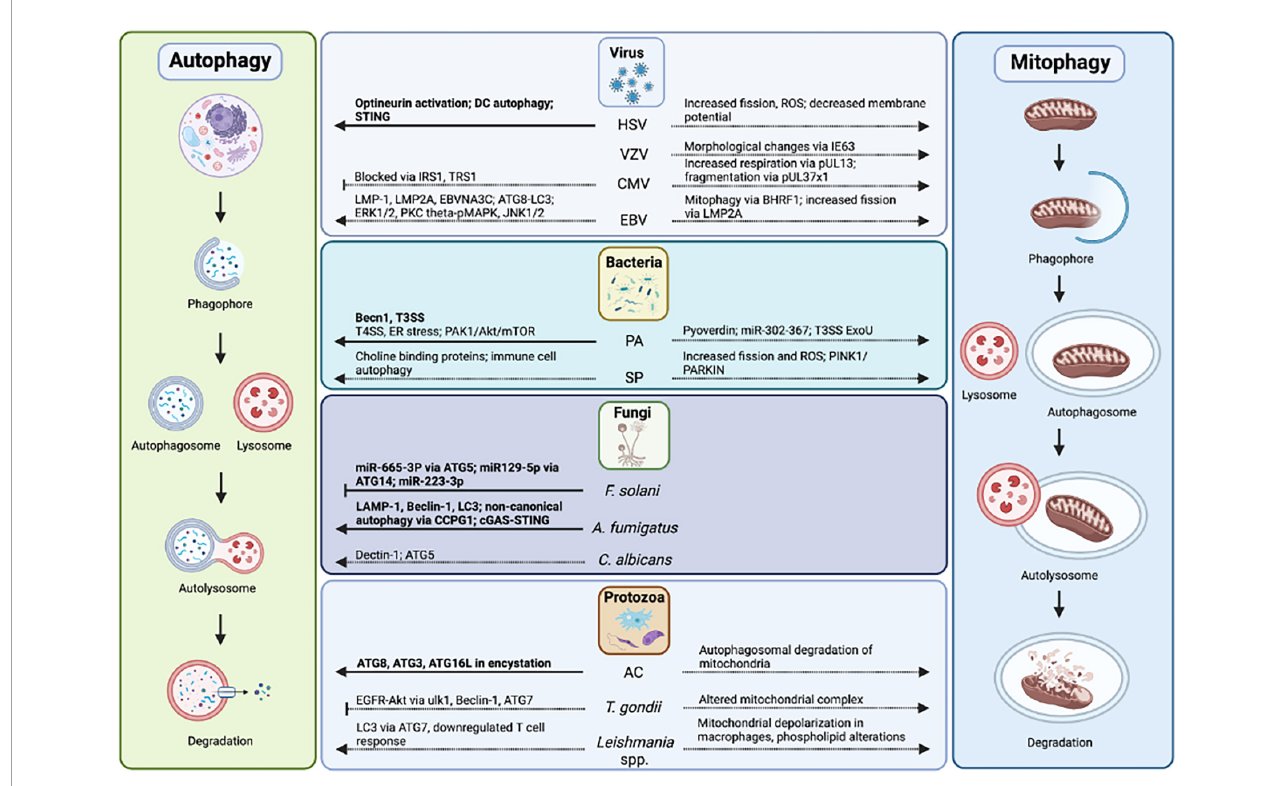
FIGURE5 Autophagy and mitophagy in infectious keratitis. Autophagy has been studied in HSV, P. aeruginosa , F. solani, A. fumigatus , and Acanthamoeba -mediated keratitis. Autophagy proteins, pathways, mitophagy, and mitochondrial changes in infectious keratitis (in bold) compared to non-ocular